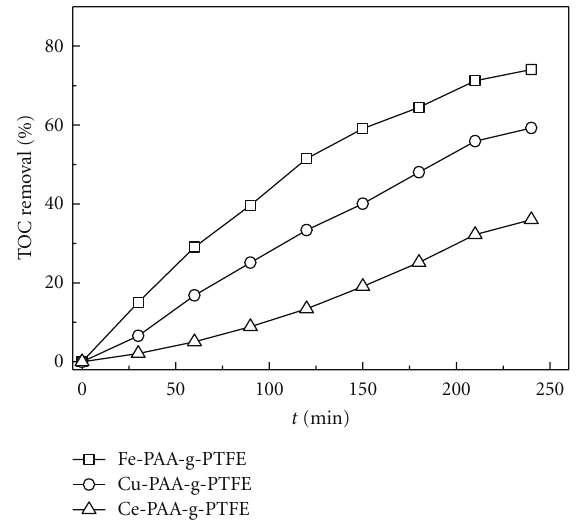
Figure 7: Mineralization of the dye with di ff erent catalysts.